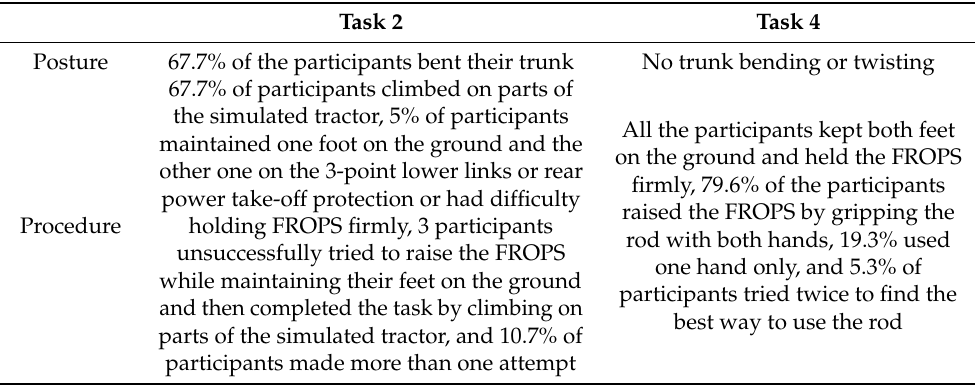
Figure 5. Participants when raising the conventional FROPS (Task 2) ( a ) adopting unbalanced postures standing on rear parts of the mock-up tractor structure, ( b ) having difficulty holding the FROPS firmly and ( c ) raising the enhanced FROPS (Task 4) from the ground by firmly grasping the rod with both hands. Table 7. Efficiency evaluation for the raising task for the two